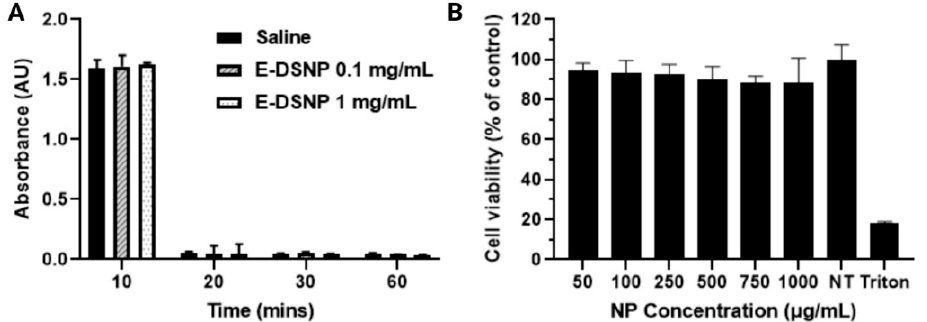
Figure 4. In vitro characterization of E-DSNPs. ( A ) E-DSNPs observed a blood clotting trend similar to that of the saline control. ( B ) In vitro cyto-compatibility of the NPs observed over 90% alveolar type-I cell viability via MTS assays.